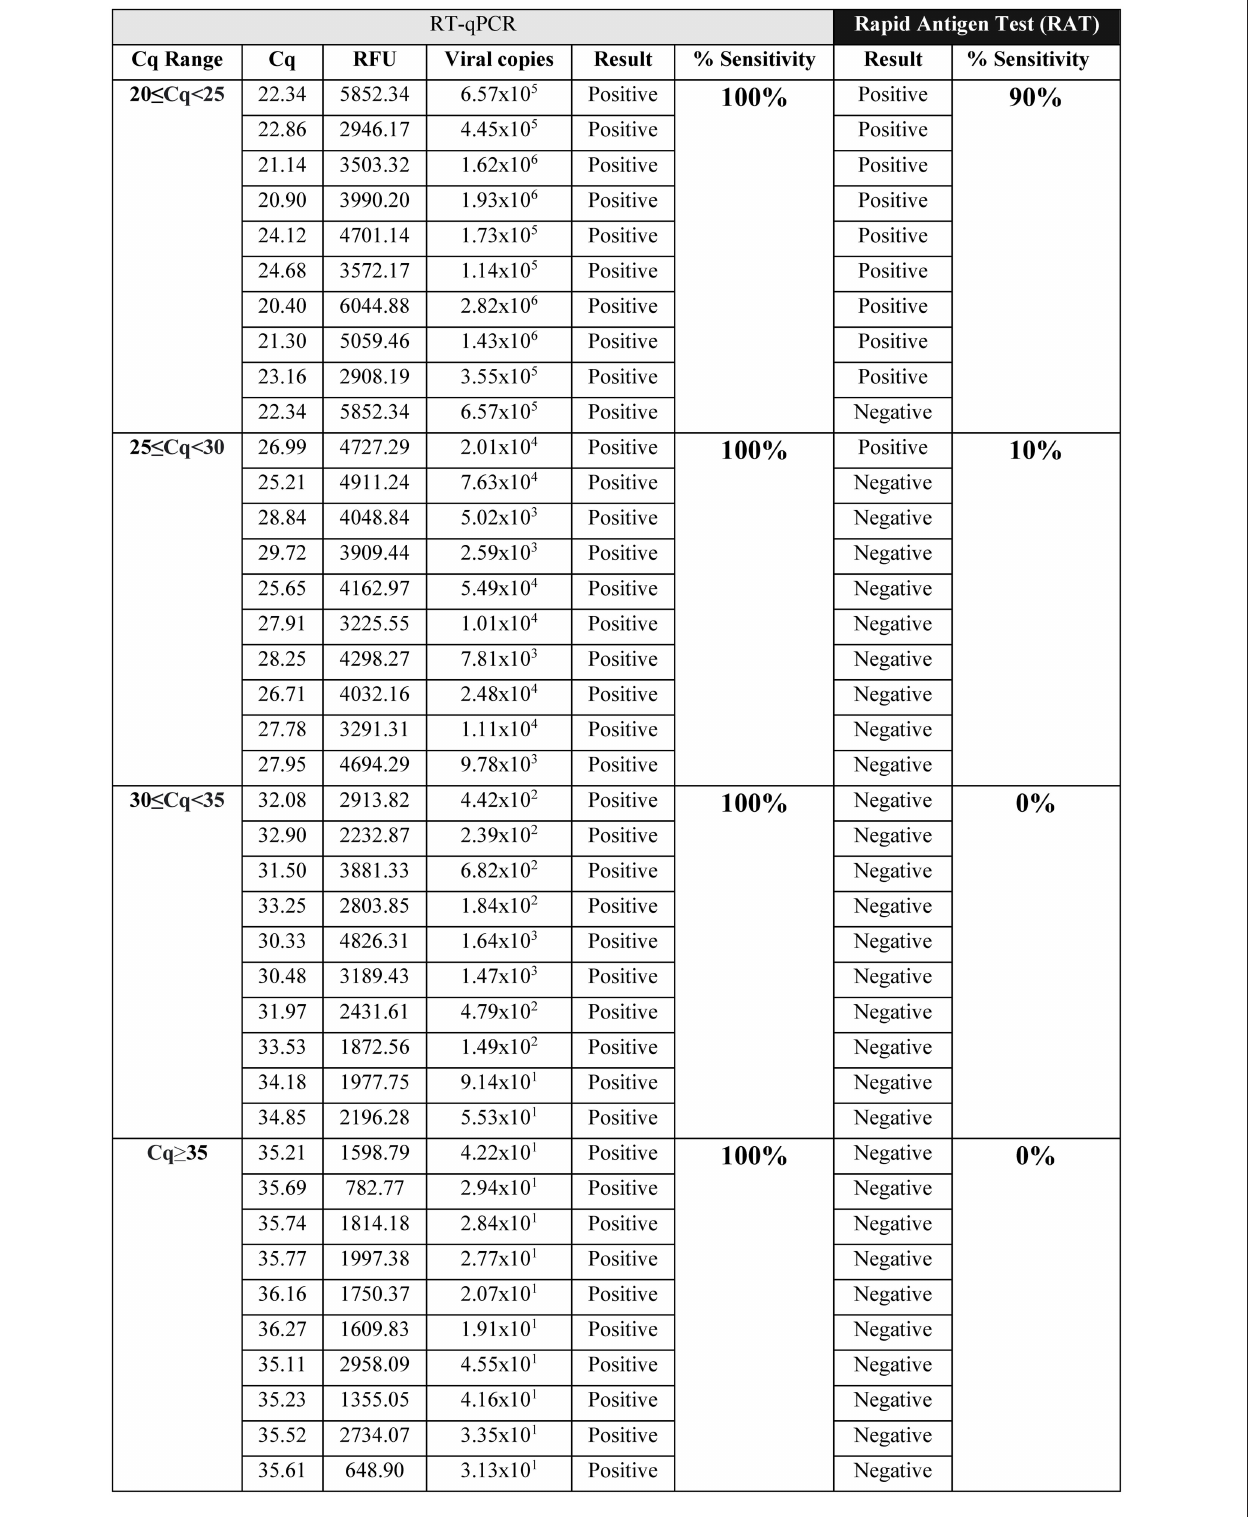
Frontiers in Public Health |